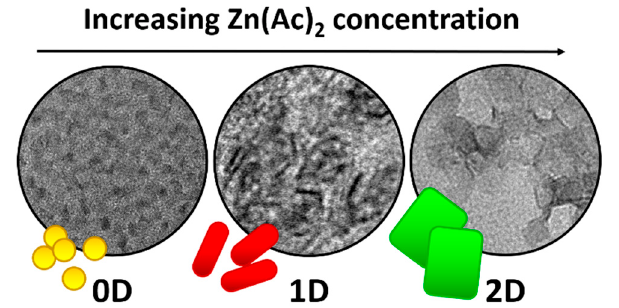
Figure 1. Schematic illustration of the shape control method: increasing the amount of Zn(Ac) 2 reagent in the initial synthesis solution causes the transition from 0D to 1D and further to 2D